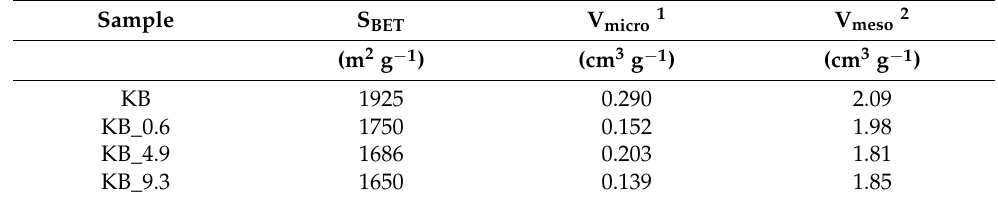
Figure 2. Differential PSDs for KB, KB_0.6, KB_4.9, and KB_9.3. Table 1. Specific surface areas, micropore volumes, and mesopore volumes of KB, KB_0.6, KB_4.9, and KB_9.3.